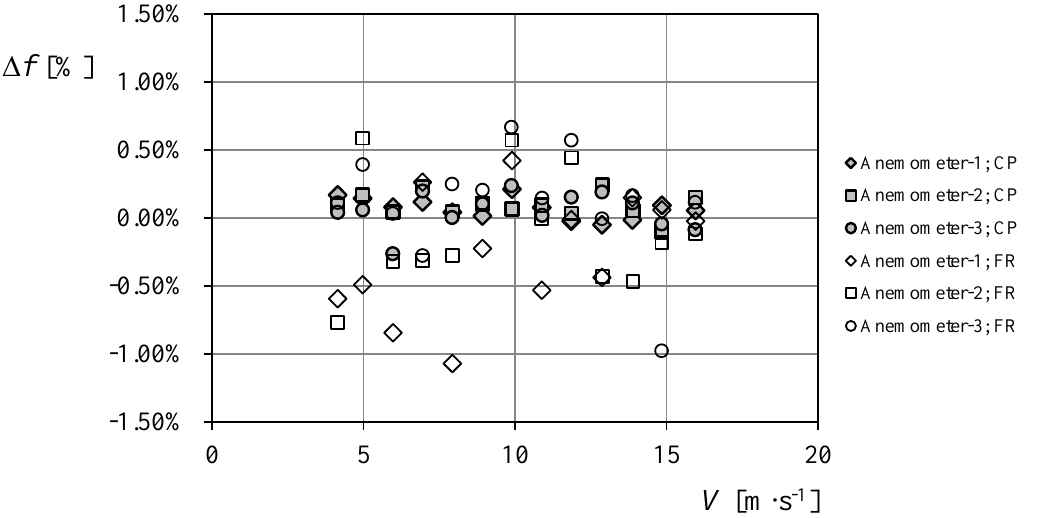
Figure 18. Percentage difference of the frequencies obtained, ∆ f (Equation (8)), from the ABDAS data measurements using the pulse-counting (CP; Equation (6)) and the Fourier transform (FR; Equation (7)) procedures, related to the ones measured with the IDR/UPM system, f IDR .